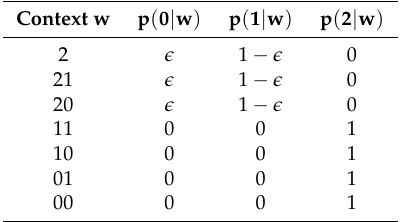
Table 1. Transition probabilities associated to the context tree τ